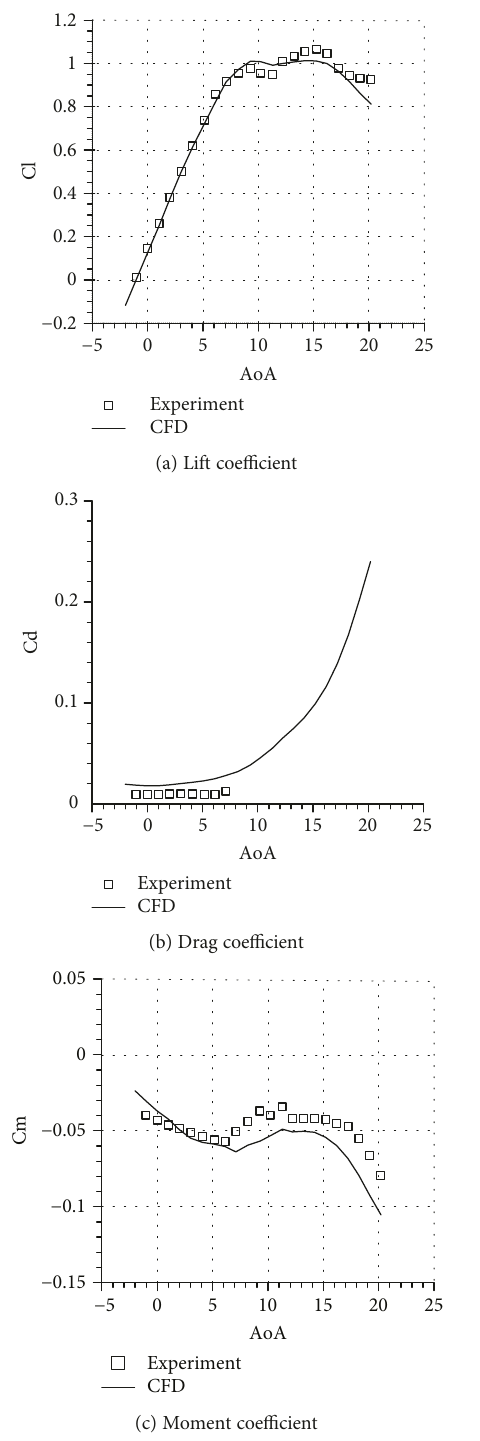
Figure 3: Comparison of aerodynamic coe ffi cients of experimental data and CFD simulations.